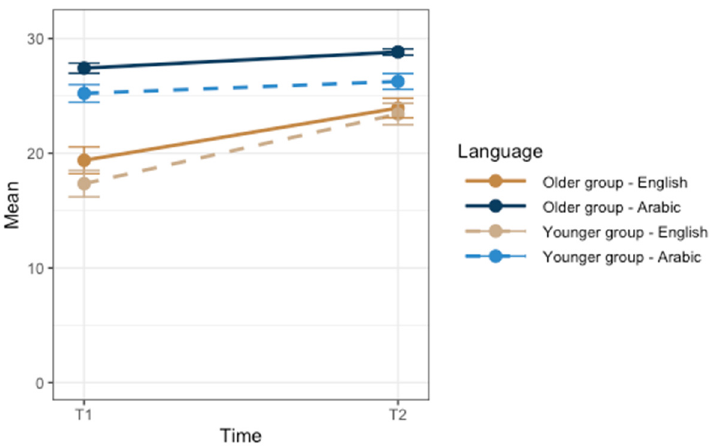
Figure 3. Participant performance at T1 and T2 in English (brown) and Arabic (blue) according to age at L2 acquisition onset (AOA) group.